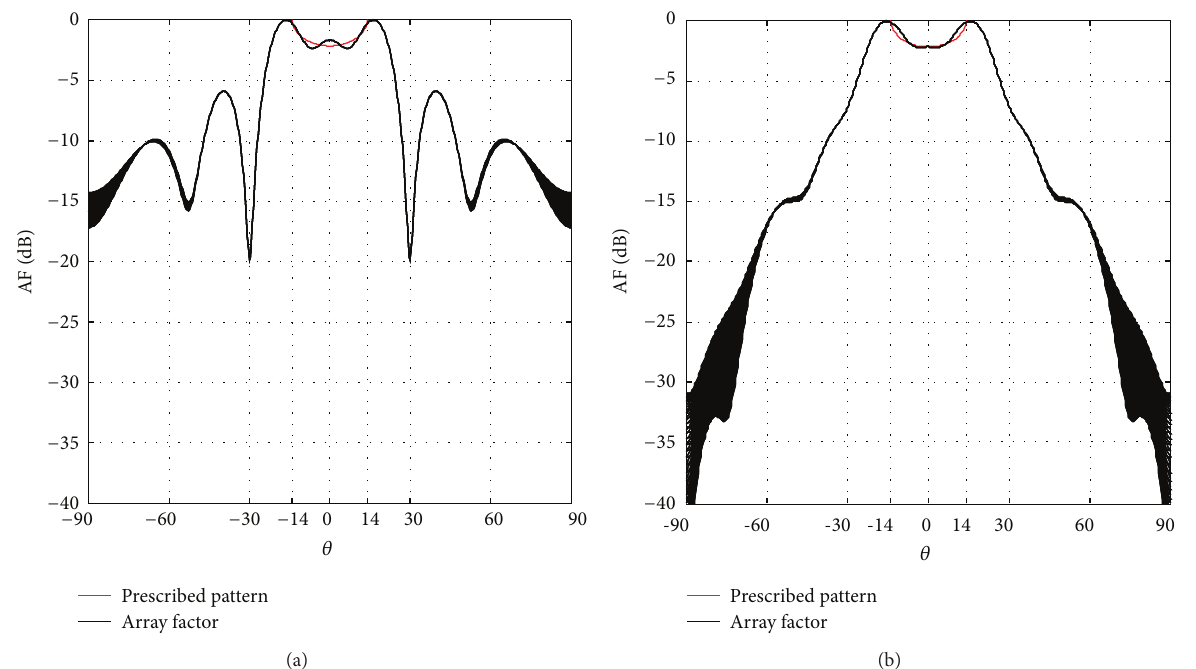
Figure 4: Isoflux radiation for MEO satellites: (a) uniform excitation and (b) concentric excitation.